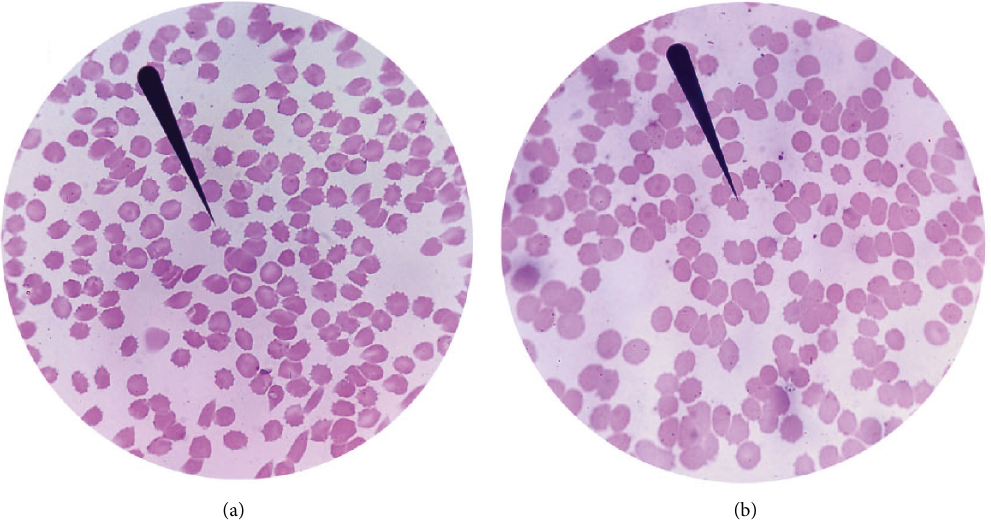
Figure 3: Storage lesion of packed erythrocytes without (a) or with (b) naringin ( × 1000). The RBCs were performed Wright’s stain. RBCs morphology including discocytes, echinocytes, sphero-echinocytes, and spherocytes was